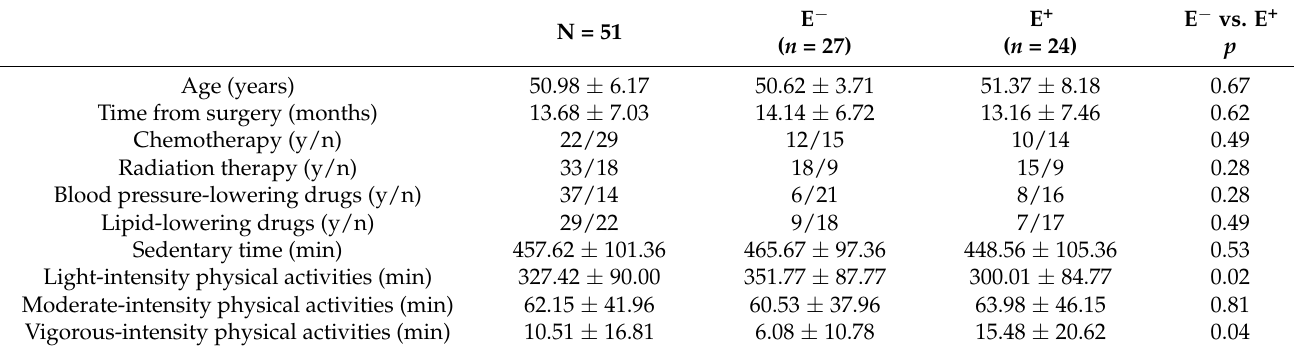
Table 1. Basal characteristics of the sample and basal differences among